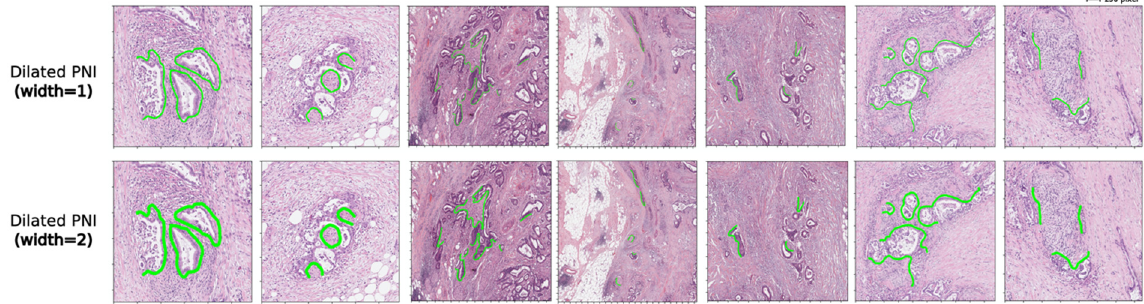
Figure 3. Examples of dilated PNI annotations for two different widths.